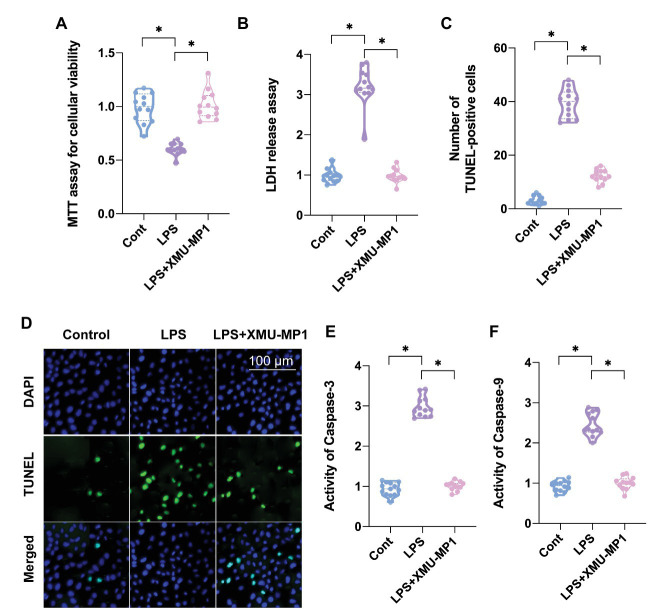
Mst2 promotes apoptosis of LPS-treated cardiomyocytes. (A) MTT assay results show the cell viability in the control, LPS-treated, and XMU-MP1 plus LPS-treated H9C2 cardiomyocytes. (B) LDH assay results show the levels of LDH in the growth medium of the control, LPS-treated, and XMU-MP1 plus LPS-treated H9C2 cardiomyocytes. (C,D) Representative TUNEL staining images and quantitative analysis of TUNEL-positive (apoptotic) cells in the control, LPS-treated, and XMU-MP1 plus LPS-treated H9C2 cardiomyocyte groups. (E,F) ELISA assay results show activated caspase-3 and caspase-9 levels in the control, LPS-treated, and XMU-MP1 plus LPS-treated H9C2 cardiomyocytes. LPS treatment was performed for 24 h. H9C2 cells were pre-treated with the Mst2 blocker, XMU-MP1 for 6 h before treatment with LPS treatment. *
p < 0.05.